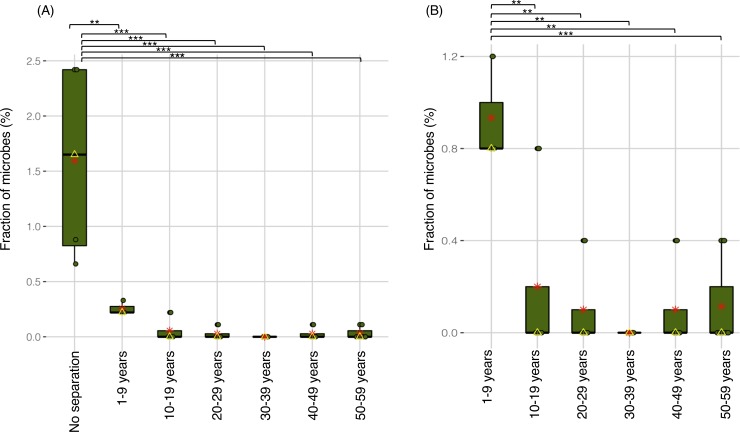
Related strains observed across all twin pairs over separation time points.Boxplots represent a fraction of the related strain found in each twin pair obtained from two data sets (twin children data from Korpela et al., and twin adult data from Xie et al.) at different separation time point intervals (no separation, 1–9, 10–19, 20–29, 30–39, 40–49, and 50–59 years). All twin children data were clustered into the no separation time point, and all twin adults data were sorted into 6 different separation time point intervals based on the days that twins have been living apart. The boxplots display the median (a yellow triangle), mean (a red asterisk), and the interquartile range. Each dot in the boxplot shows a value observed per each twin pair, and the whiskers of the box are extended to the lowest and highest value found in each separation time points. Boxplots were generated using the ggplot2 package (version 3.1.1) in R (version 3.5.1). (A) Significant differences (P-value <0.05) between no separation vs. each separation time point interval were tested using an ANOVA followed by Tukey’s multiple-comparisons post hoc tests in R (version 3.5.1), and represented as a black asterisk above the boxplot; *P-value <0.05, **P-value <0.01, ***P-value <0.001, n.s. = not significant (See S3 Table for detailed values). (B) Significant differences (P-value <0.05) within the various separation time point intervals, specifically when 1–9 years was compared to the rest of the time point intervals 10–19, 20–29, 30–39, 40–49, and 50–59 years) were tested using the same statistical analysis in the panel (A).